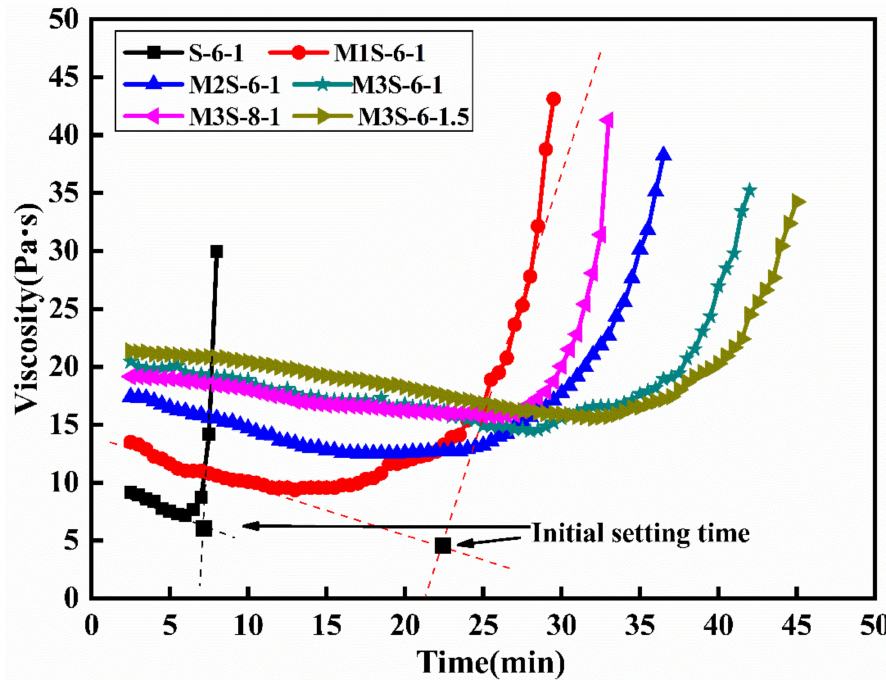
Figure 4. Viscosity of alkali-activated slag with different metakaolin content, activator modulus, and Na 2 O